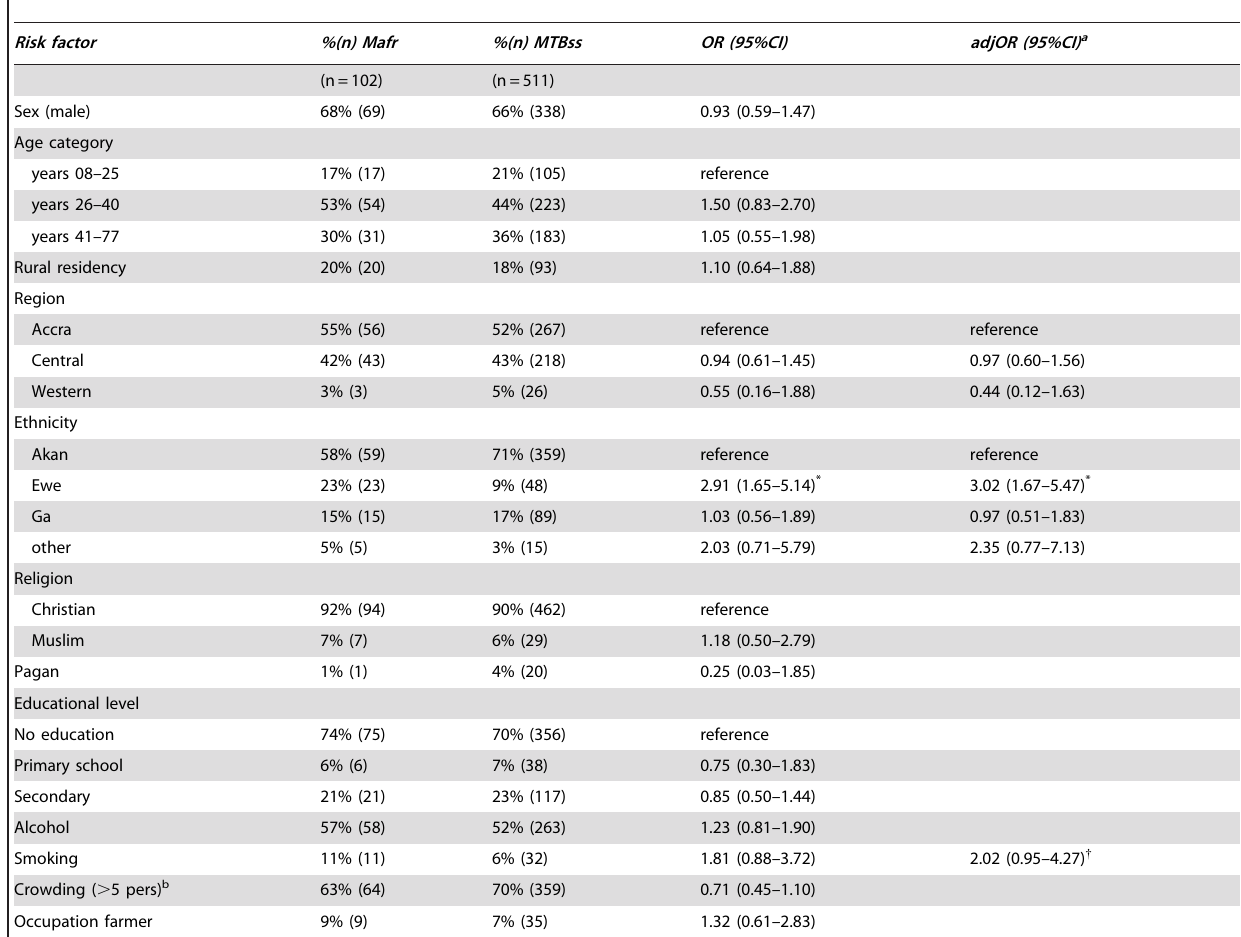
Table 3. Risk factors for TB caused by M. africanum compared to M. tuberculosis sensu stricto.